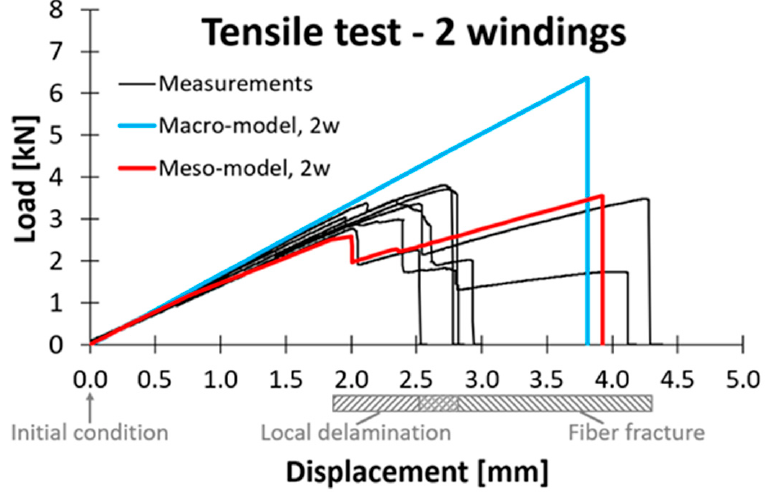
Figure 17. Load-displacement curves from tensile tests on simple loops with two windings (measured and calculated).